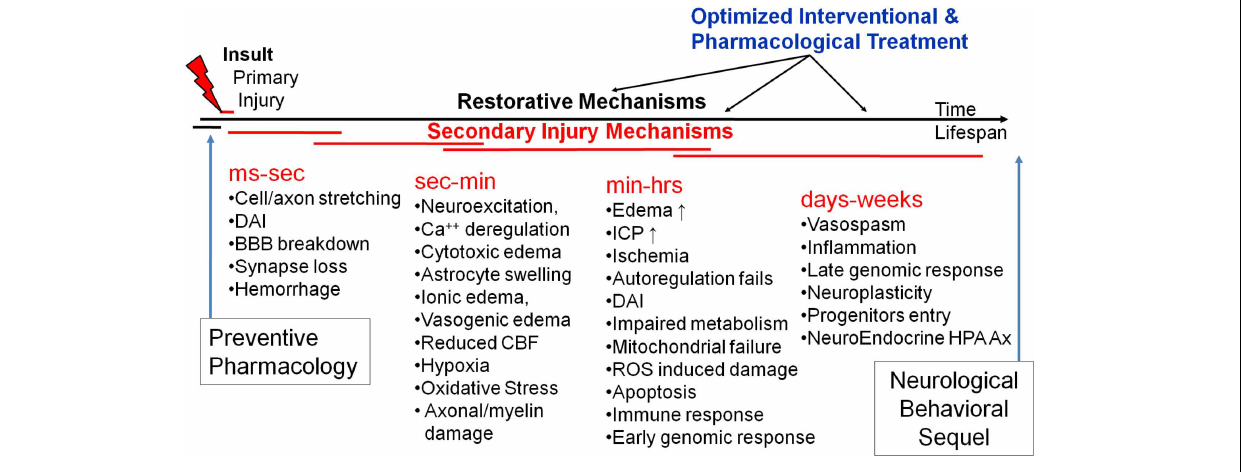
FIGURE 5 |A schematic of time-structured secondary brain injury mechanisms and potential windows for pharmacological intervention .